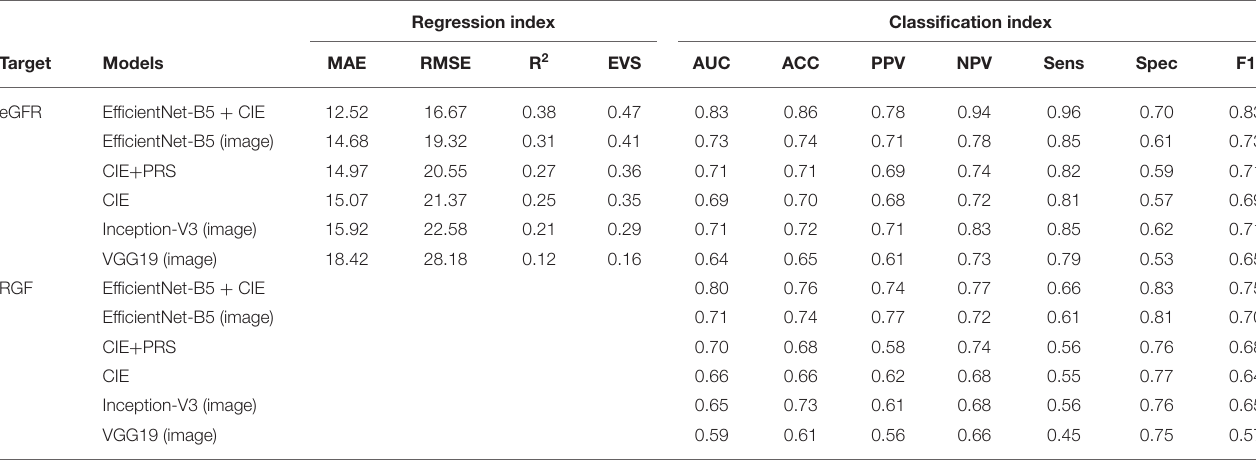
TABLE 2 | Prediction of postoperative stable graft function